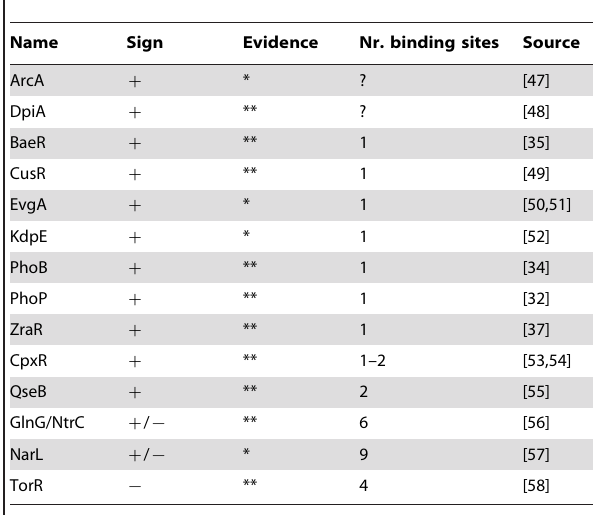
Table 1. Auto-regulating response regulators in E. coli